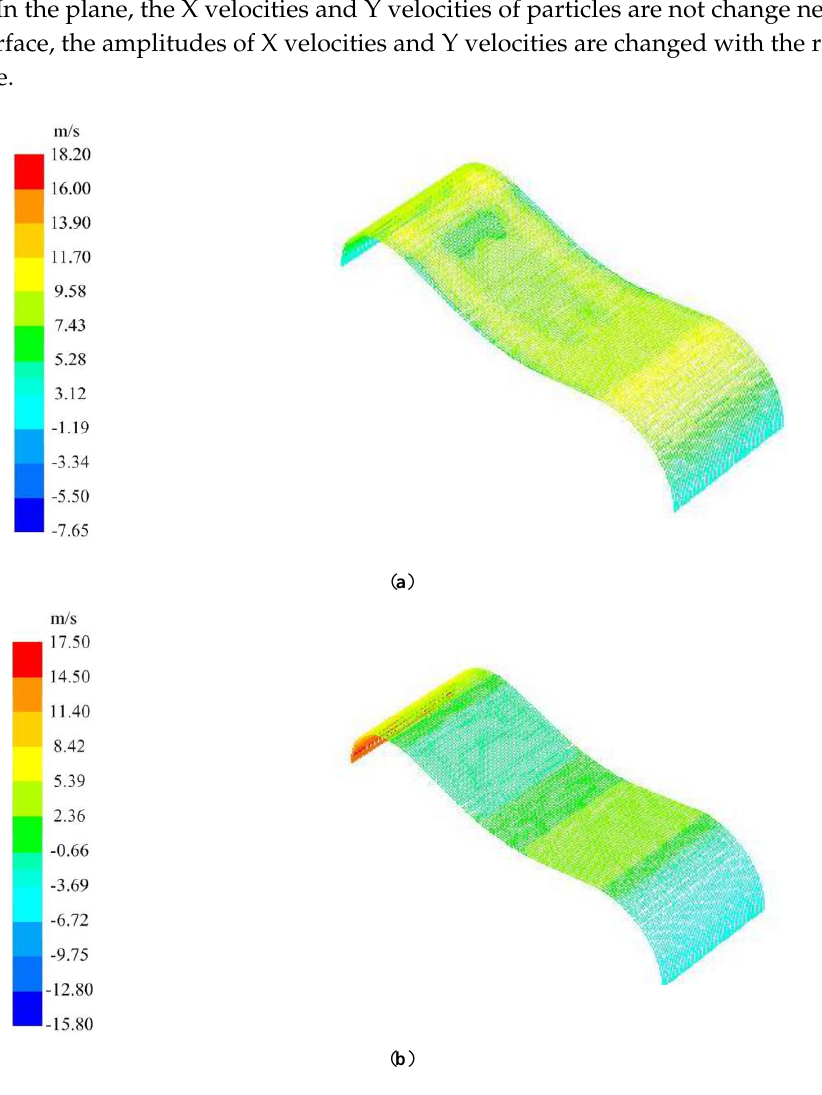
Figure 9. Velocity vectors of particles: ( a ) X velocities of particles; and ( b ) Y velocities of particles. The X/Y velocities of particles can be obtained by CFD method, but the tangential velocity must be obtained by calculation for further study, as shown in Figure 10. The trend of the tangential velocity in L1 and L5 is similar to the Y velocity, and the maximum in L1 is bigger than in L5. In L2, the tangential velocity is gradually decreased, but, in L4, the tangential velocity is gradually decreased and the changing speed is smaller. In L3, the tangential velocity is gradually increased. On the curved surface, the bigger the radius of the curved surface is, the more quickly the velocity of the particle changes.